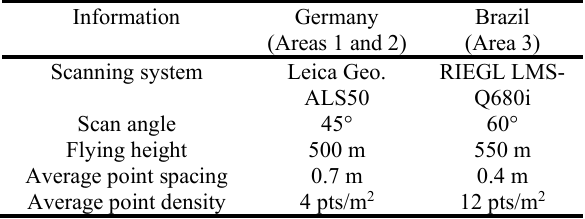
Table 1. Characteristics of the airborne LiDAR datasets considered in the